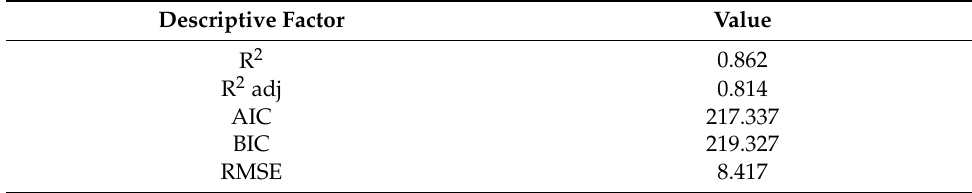
Table 4. Selected regression model.